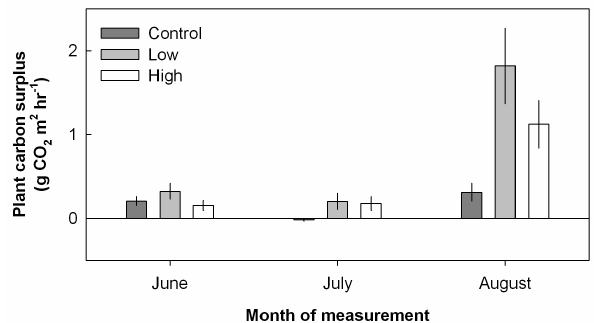
Fig. 3. Plant carbon surplus potential – calculated as GPP at a light intensity of 600µmolm − 2 s − 1 minus R uv – in plots with different N addition rates over the growing season. Error bars represent SE ( n = 17 and 2 for GPP and R uv respectively). R uv values were derived from Hasselquist et al. (2012) from locations <20m from the points measured in this study in all plots and measurement